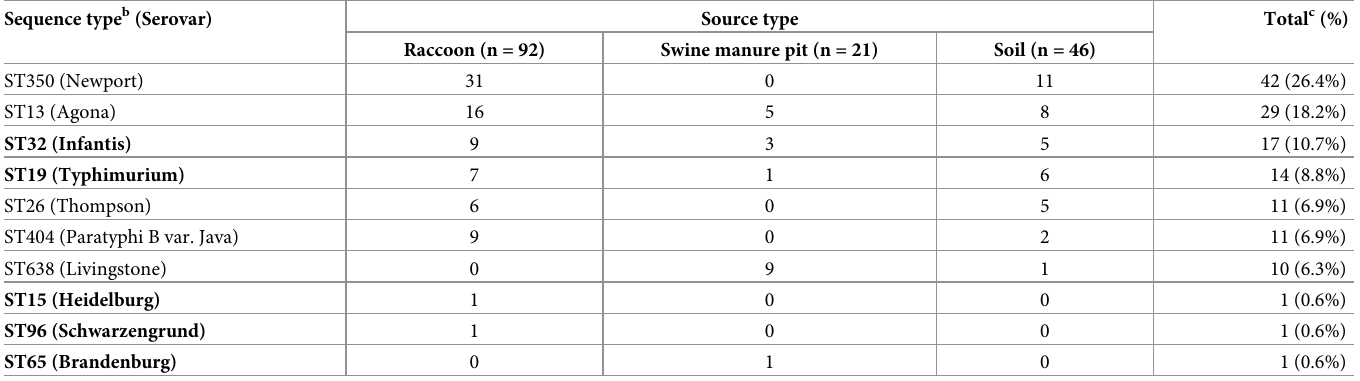
Bolded STs represent internationally recognized sequence types implicated in human illness. a Three isolates (two from raccoons, one from soil) were not typeable. b Sequence types (STs) determined using 7-loci Achtman scheme.